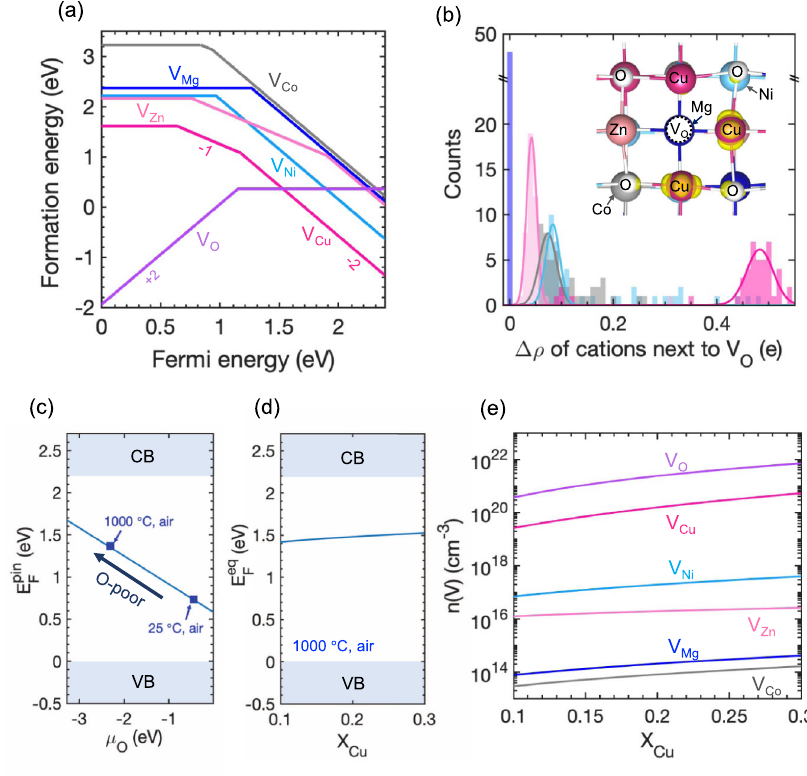
Fig. 3 Charge compensation and localization from point defects in (Mg 0.2 Ni 0.2 Co 0.2 Cu 0.2 Zn 0.2 )O. a Formation energy of oxygen and cation vacancies as a function of Fermi level assuming bulk growth conditions (1000 °C, air). An oxygen vacancy is a deep donor while cation vacancies are deep acceptors. b The histogram and fi ts of the change in Bader charge of 1NN cations before and after the formation of an oxygen vacancy. The inset illustrates the local atomic structure of the entropy-stabilized oxide with the lowest-formation-energy oxygen vacancy and the isosurface of the band-decomposed charge density at the conduction band minimum (CBM). The value of the isosurface is chosen to be 50% of the charge density. The charge distribution of excess electrons from an oxygen vacancy (yellow) is localized on the nearest Cu atoms. c Calculated Fermi-level pinning energy as a function of oxygen chemical potential. The characteristic oxygen chemical potential and Fermi level pinning energy under bulk (1000 °C, air) synthesis conditions as well as standard ambient temperature and pressure (25 °C, air) are speci fi ed. Under typical growth conditions, the Fermi energy is pinned at a deep energy level within the band gap, in agreement with the observation of the electrically insulating state of (Mg 0.2 Ni 0.2 Co 0.2 Cu 0.2 Zn 0.2 )O. d Calculated equilibrium Fermi energy level as a function of Cu mole fraction. The mole fraction for the non-variable cations equally composes the remaining mole fraction. Increasing Cu composition leads to increased charged oxygen vacancy formation, which enhances the equilibrium Fermi level toward CBM. e Calculated equilibrium vacancy concentration of oxygen and cations as a function of Cu mole fraction. By utilizing the local con fi guration effect on oxygen vacancy formation energy and the subsequent cation vacancy formation for charge neutrality, the vacancy density of ESO can be tuned by cation mole